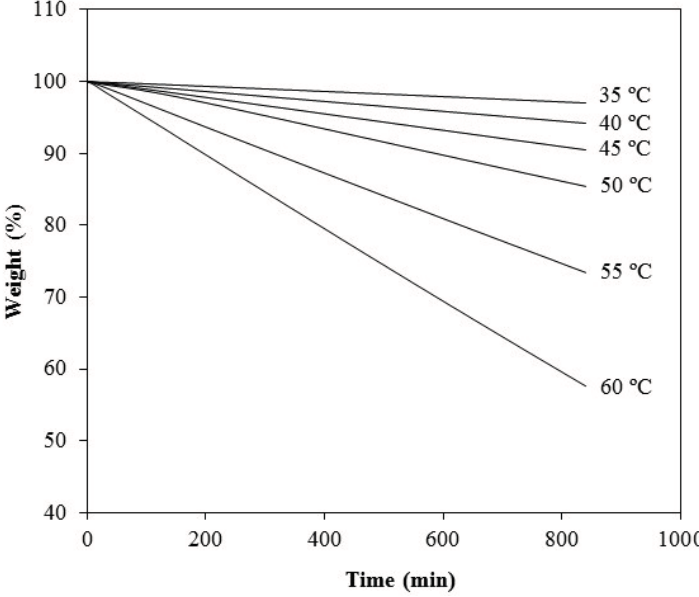
Figure 4. Time-dependent isothermal scans of pure G-0 in the temperature range of 35 to 60